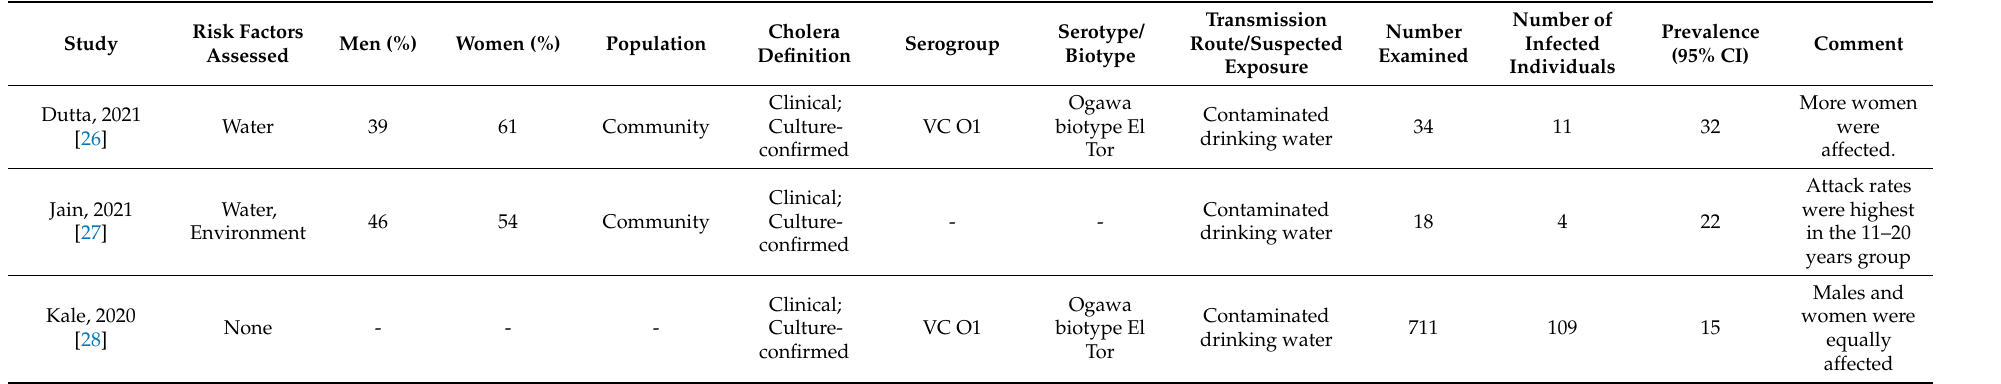
Table A2. Sources of